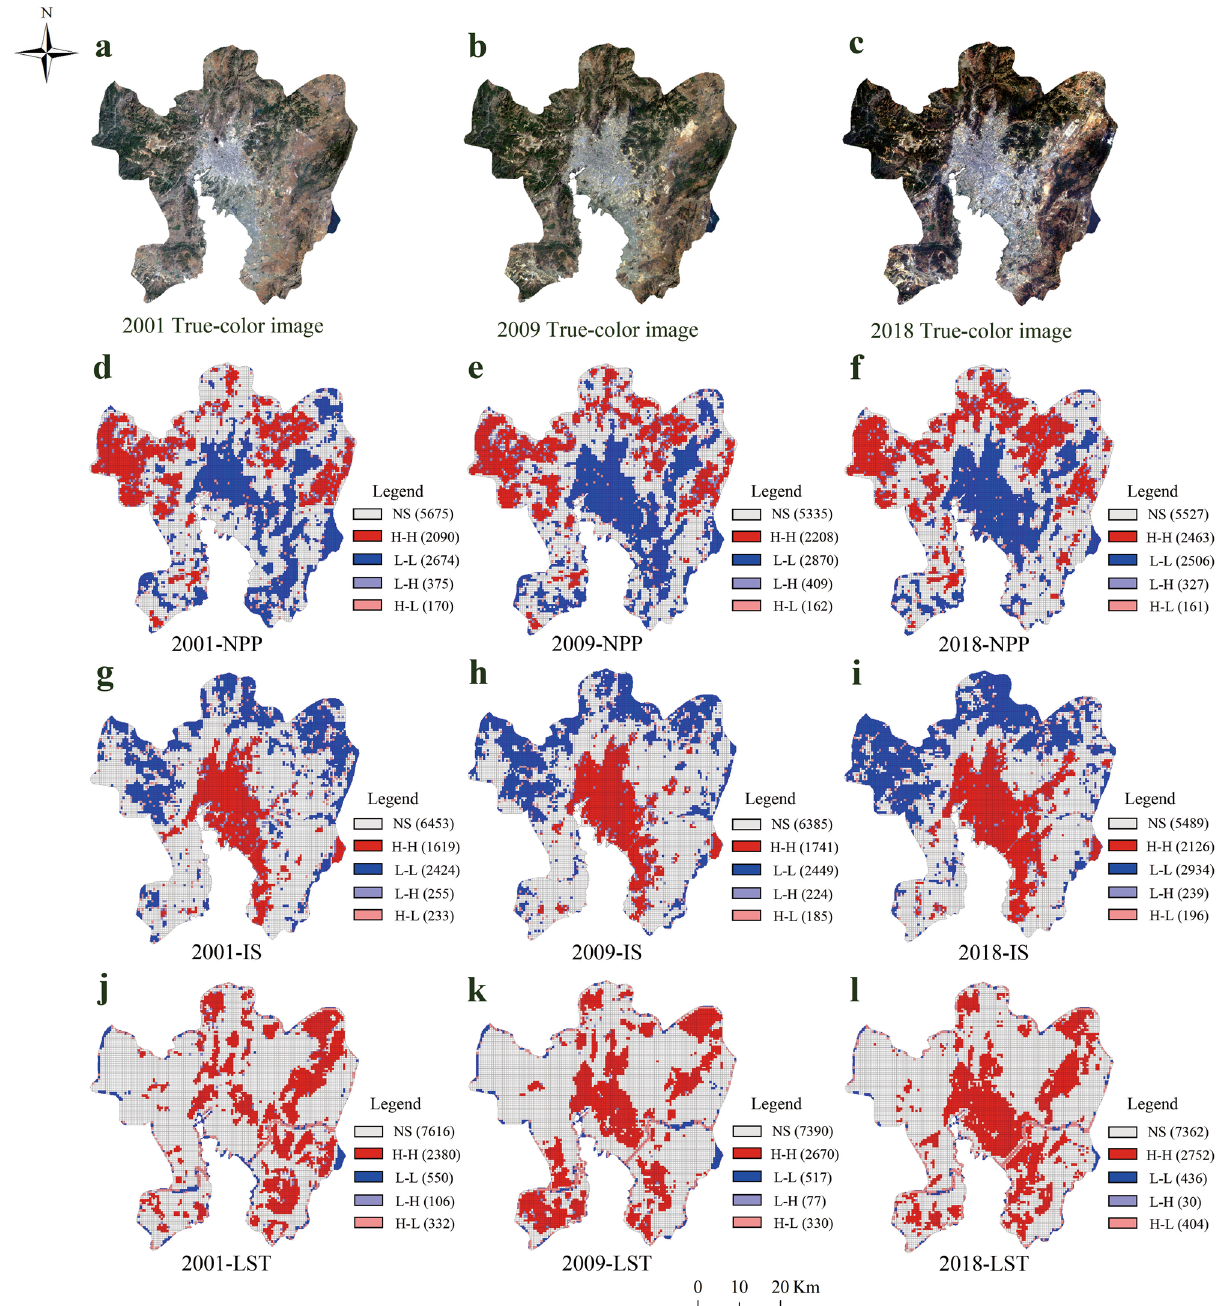
Figure 1. LISA cluster maps of NPP, IS and LST. ( a – c ) are the true color images of Kunming; ( d – l ) are the LISA cluster maps of NPP, IS and LST in 2001, 2009, and 2018. NS means not significant. H–H means high–high clusters. L–L means low–low clusters. L–H means low–high clusters. H–L means high–low clusters. In addition, NPP is net primary productivity. IS is impervious surface. LST is land surface